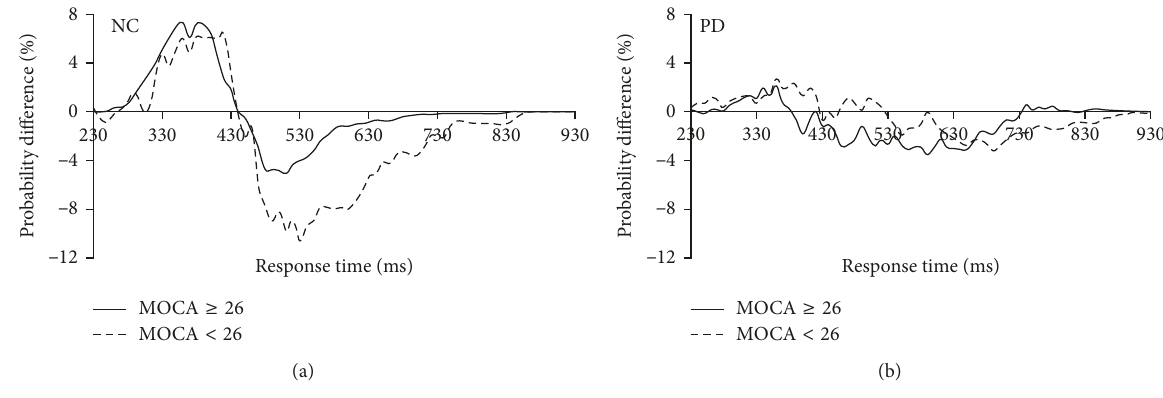
Figure 4: Direct comparison of audiovisual performance relative to the predicted race model. Significant audiovisual integration was found in both NC with (dotted line) and without (solid line) cognitive impairment (a). No significant audiovisual integration was occurred with (dotted line) or without (solid line) cognitive impairment